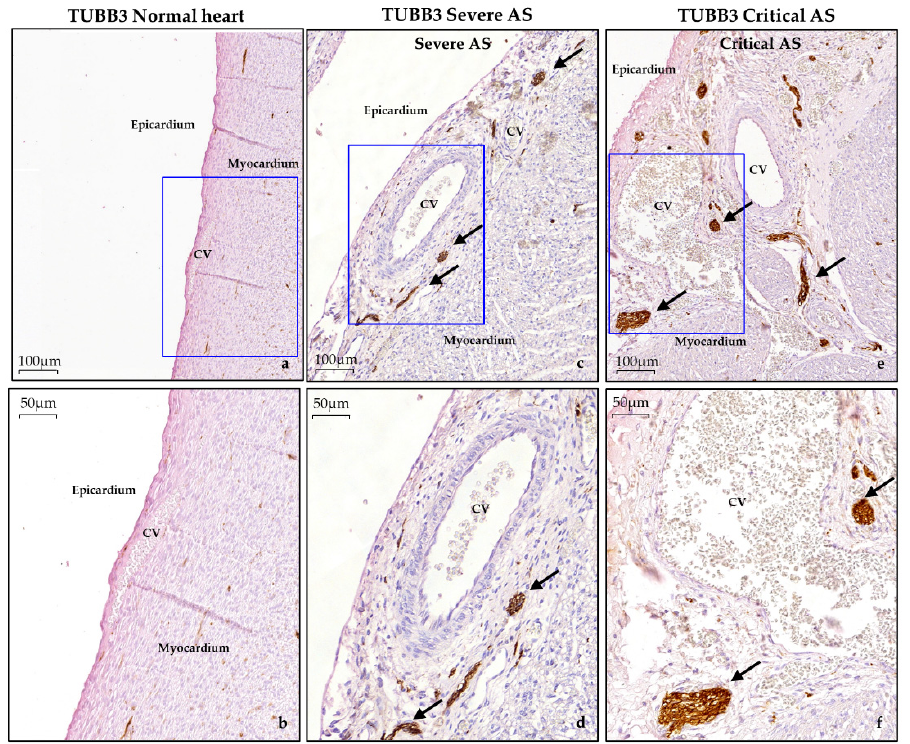
Figure 6. Abnormal epicardial thickening with dilated coronary vessels and large nerves in aortic stenosis cases. Representative images of the epicardium at two magnifications in: ( a , b ) normal hearts; ( c , d ) severe aortic stenosis; ( e , f ) critical aortic stenosis. Note the remarkable thickened epicardium containing dilated coronary vessels and large nerves (brown) in cases with aortic stenosis. TUBB3, β III-tubulin; CV, coronary vessel.